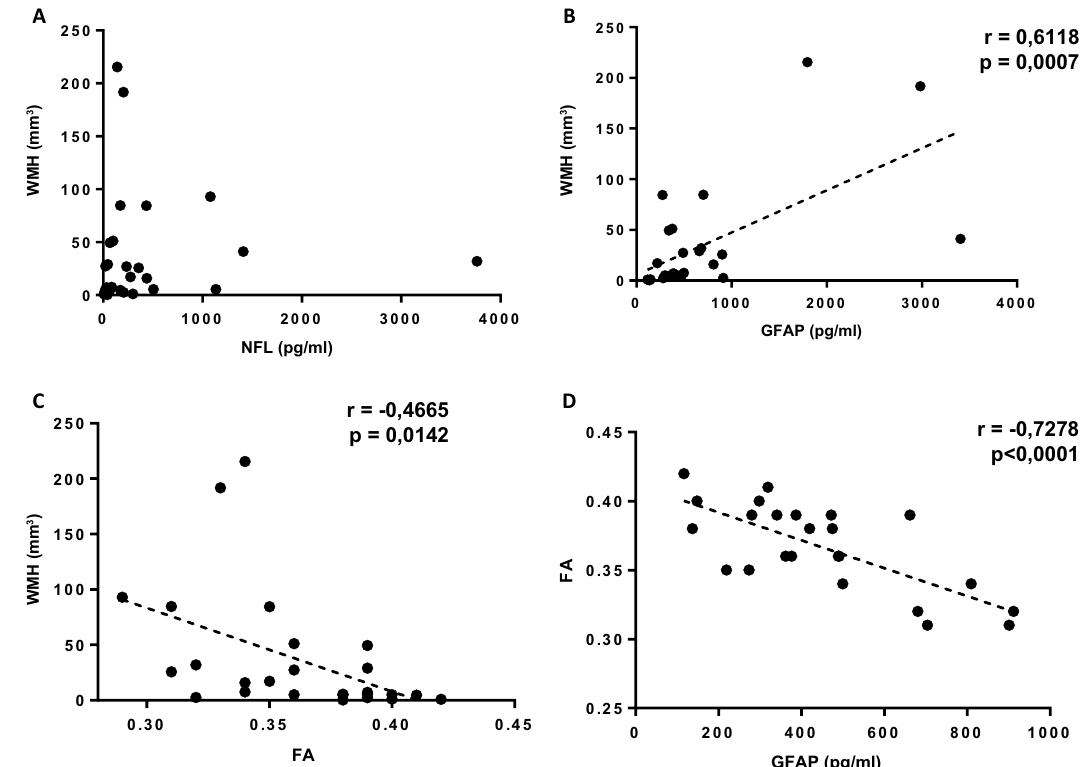
Figure 3. Correlation analyses between WMH vs. NF-L ( A ), WMH vs. GFAP ( B ), WMH vs. FA ( C ) and FA vs. GFAP ( D )in pDoC patients. The values of Pearson correlation coefficients (r) and p - values are reported inside the